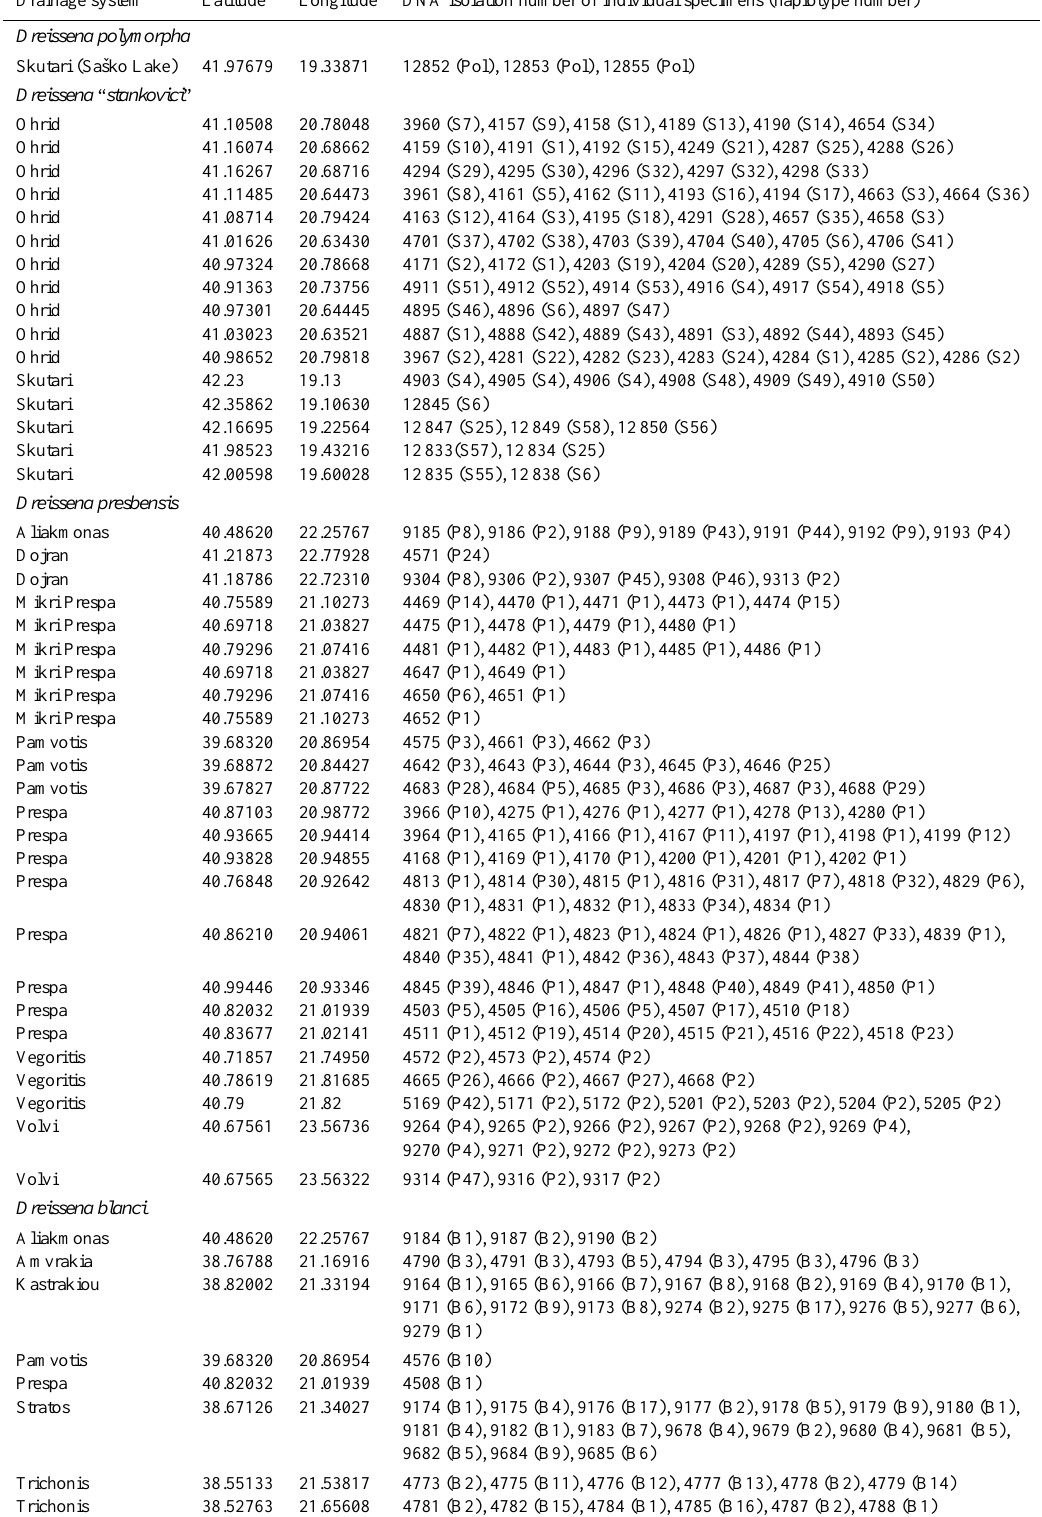
Table 1. Locality information of studied specimens of Dreissena spp., including drainage system, latitude and longitude information (in decimal degrees N and W, respectively), as well as DNA isolation numbers and respective haplotype information for individual specimens (in